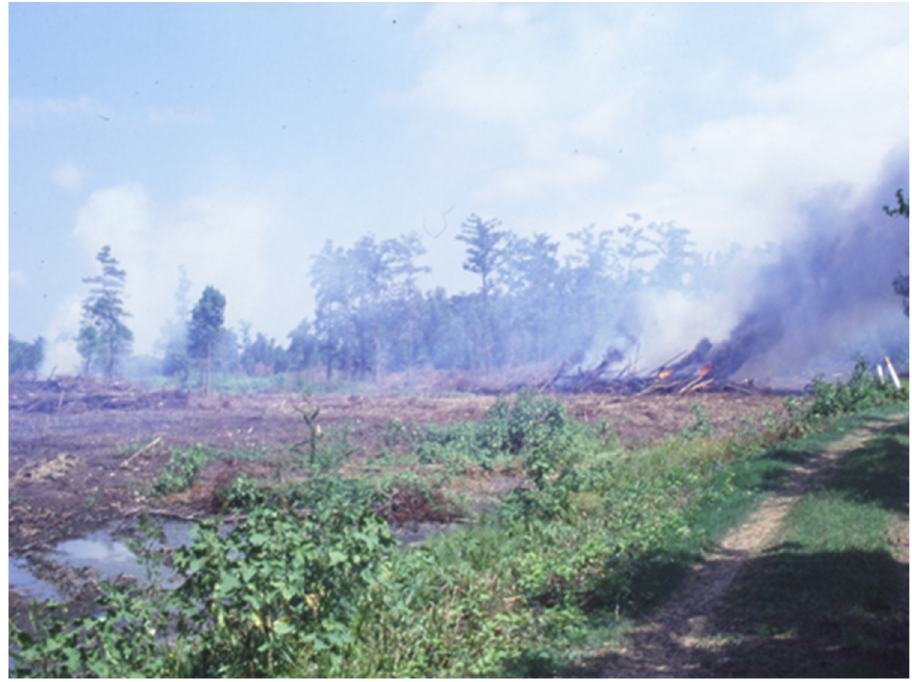
Figure 4. Clearance and burning of bottomland hardwood forests to convert to agricultural land in Louisiana, United States. Source: Edward Maltby.